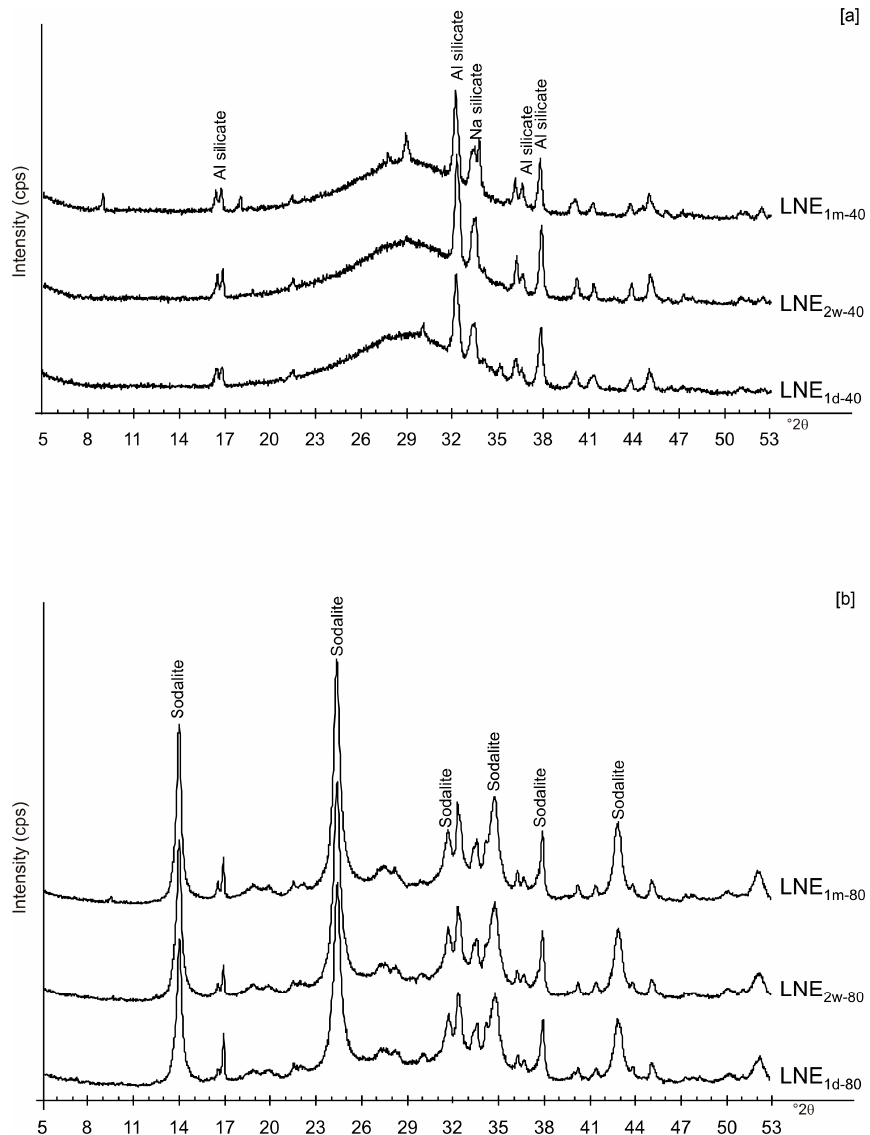
Figure 7. XRD pattern of LN samples after ethanol washing and drying at ( a ) 40 °C and ( b ) 80 °C.